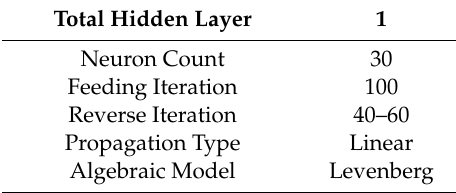
Table 3. Utilized feedforward back propagation neural network (FFBP-NN) structure.